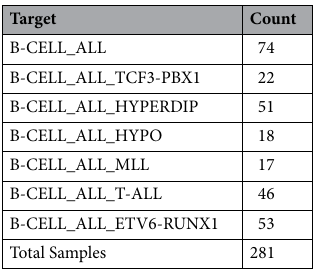
Table 5. Target count for each class in Leukemia_GSE28497 dataset.